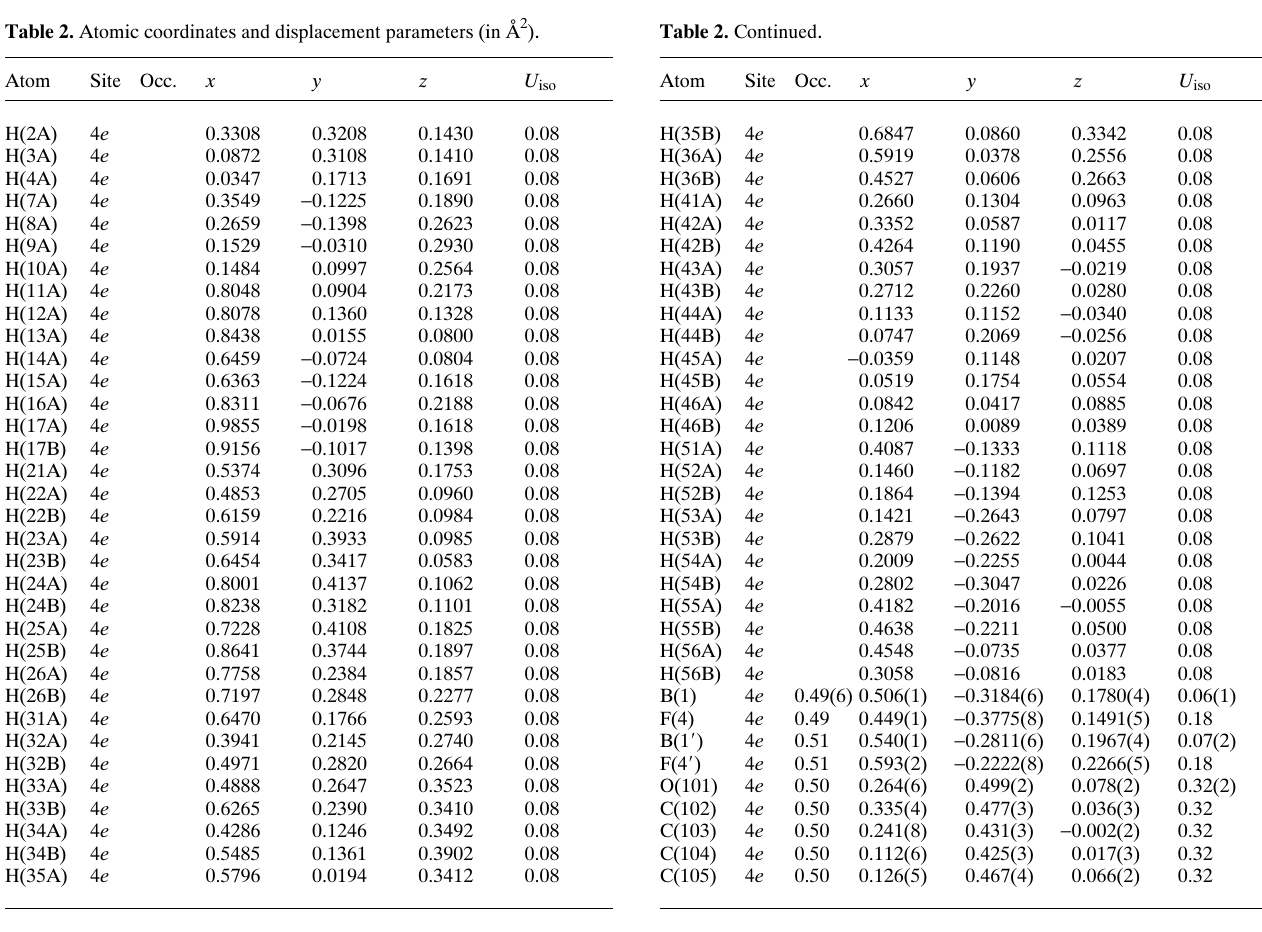
1. 1-(2-(Dicyclohexylphosphinophenyl)pyrol-2-dicyclo- hexylphosphino-rhodium(I) norborna-2,5-diene tetrafluoroborate tetrahydrofuran